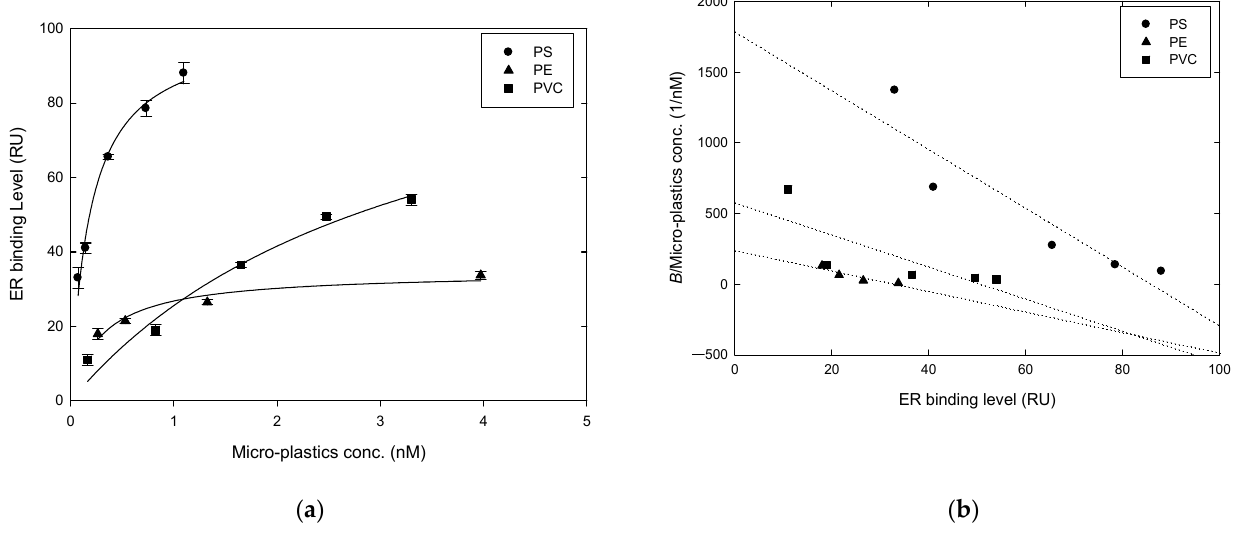
Figure 6. Specificity test for micro-plastics to estrogen receptors by SPR. Various concentrations of micro-plastics reacted with the same concentration of ERs immobilized on the chip, and SPR was utilized to observe the relationship between micro-plastics’ concentration and binding level of ER. ( a ) The Langmuir equation was used to plot the binding level of micro-plastics to ERs, showing that the three micro-plastics each had a different affinity for the ERs. ( b ) Plot according to ( a ) of the obtained ER binding level, bound amounts and micro-plastics’ concentration at which the dissociation constant was obtained. All data were repeated twice; ( b ) was calculated with numerical averages. Reaction volume: 30 µ L; reaction flow rate: 50 μ L/min.